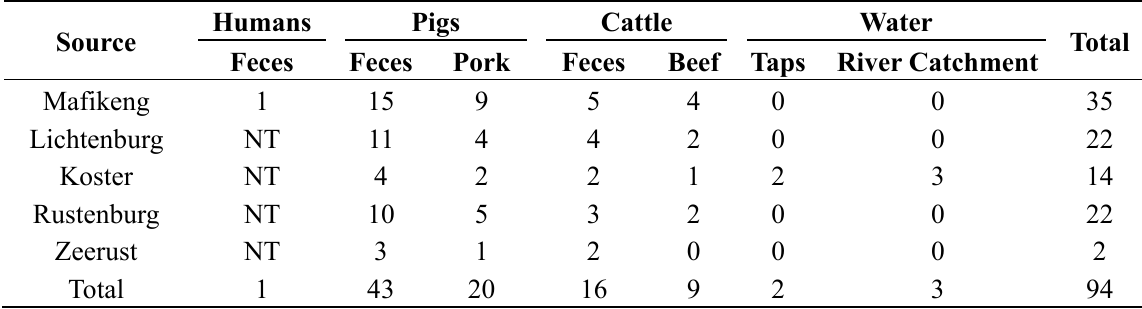
Table 3. Number of E. coli O157:H7 isolates from the different species and/or sources that were used for genotypic typing. NT, not